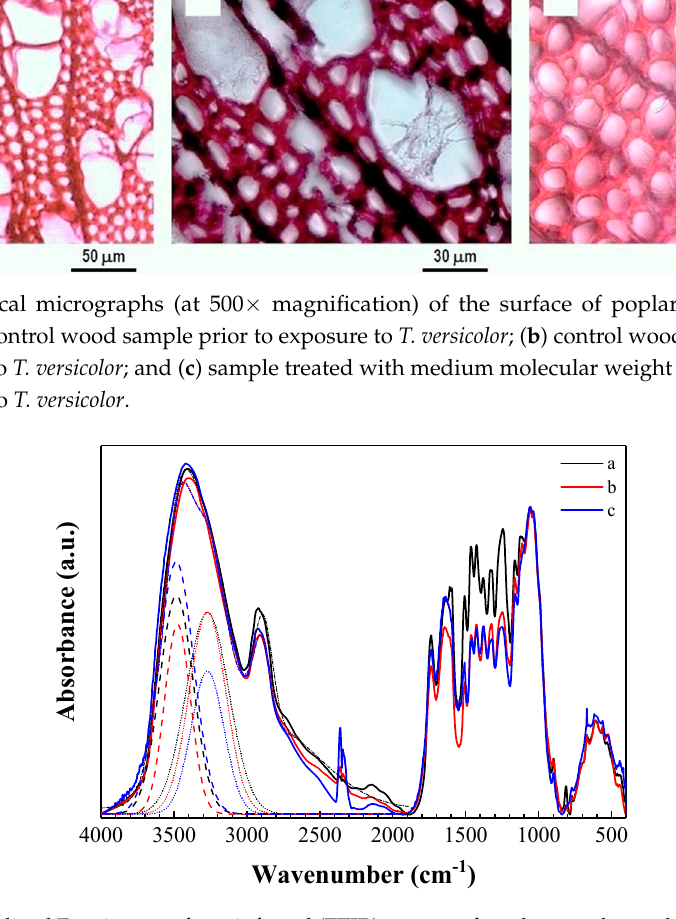
Figure 3. Normalized Fourier transform infrared (FTIR) spectra of poplar wood samples: ( a ) undecayed control wood sample prior to exposure to T. versicolor ; ( b ) control 30 days after exposure to T. versicolor ; and ( c ) sample treated with medium molecular weight chitosan 30 days after exposure to T. versicolor . A deconvolution of O–H (dashed lines) and N–H (dotted lines) bands, together with the cumulative peak fit (short dash-dot lines), is shown.